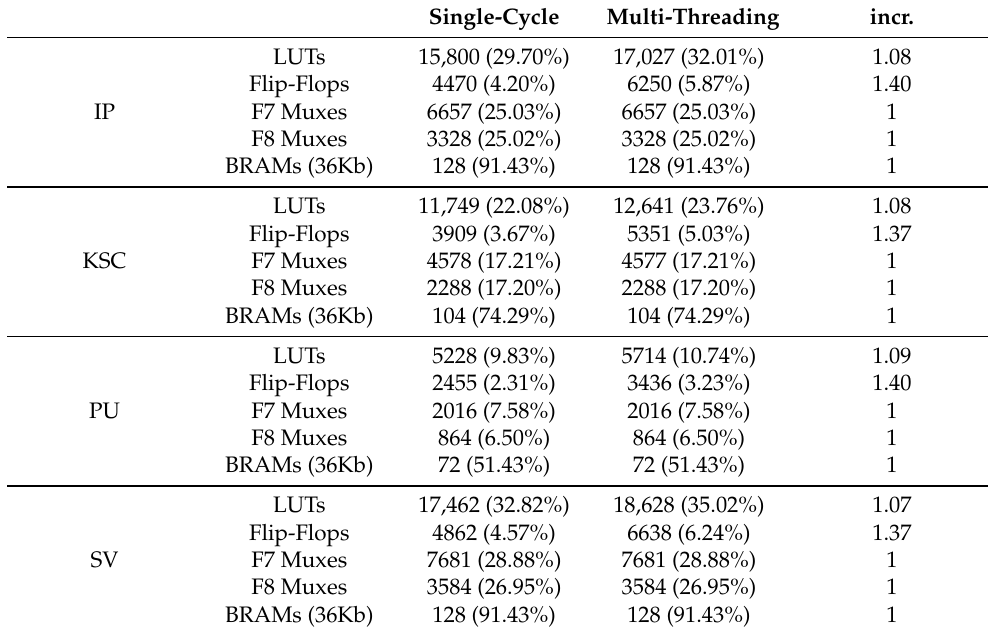
Table 2. Single-cycle vs. multi-threading